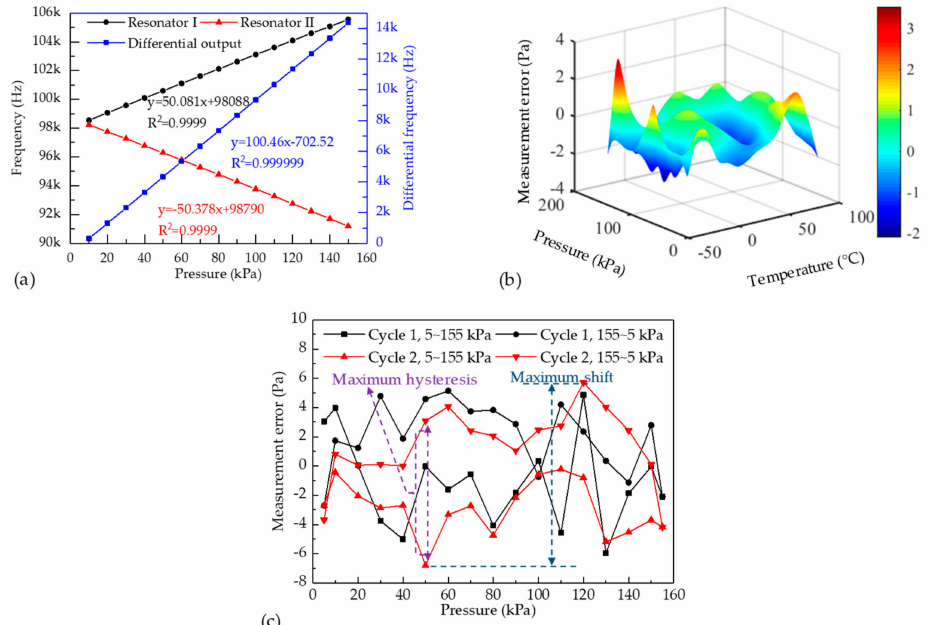
Figure 6. ( a ) Frequency responses to atmospheric pressure under measurement in room temperature; ( b ) the atmospheric pressure measurement errors in the pressure range of 10 to 150 kPa and temperature range of − 45 to 85 ◦ C; ( c ) plots of cycling measurement errors to atmospheric pressure under measurement under room